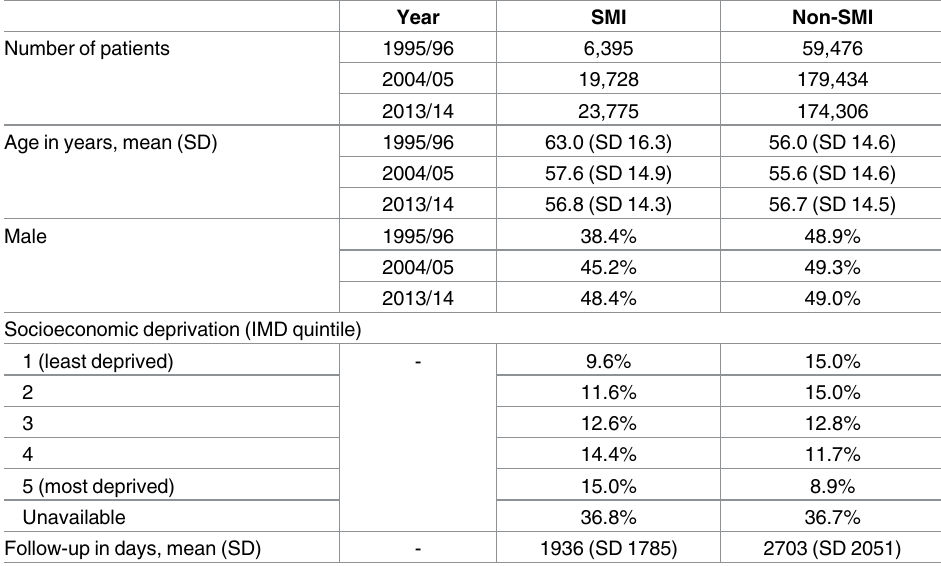
Table 1. Demographic characteristics of patients with and without severemental illness.